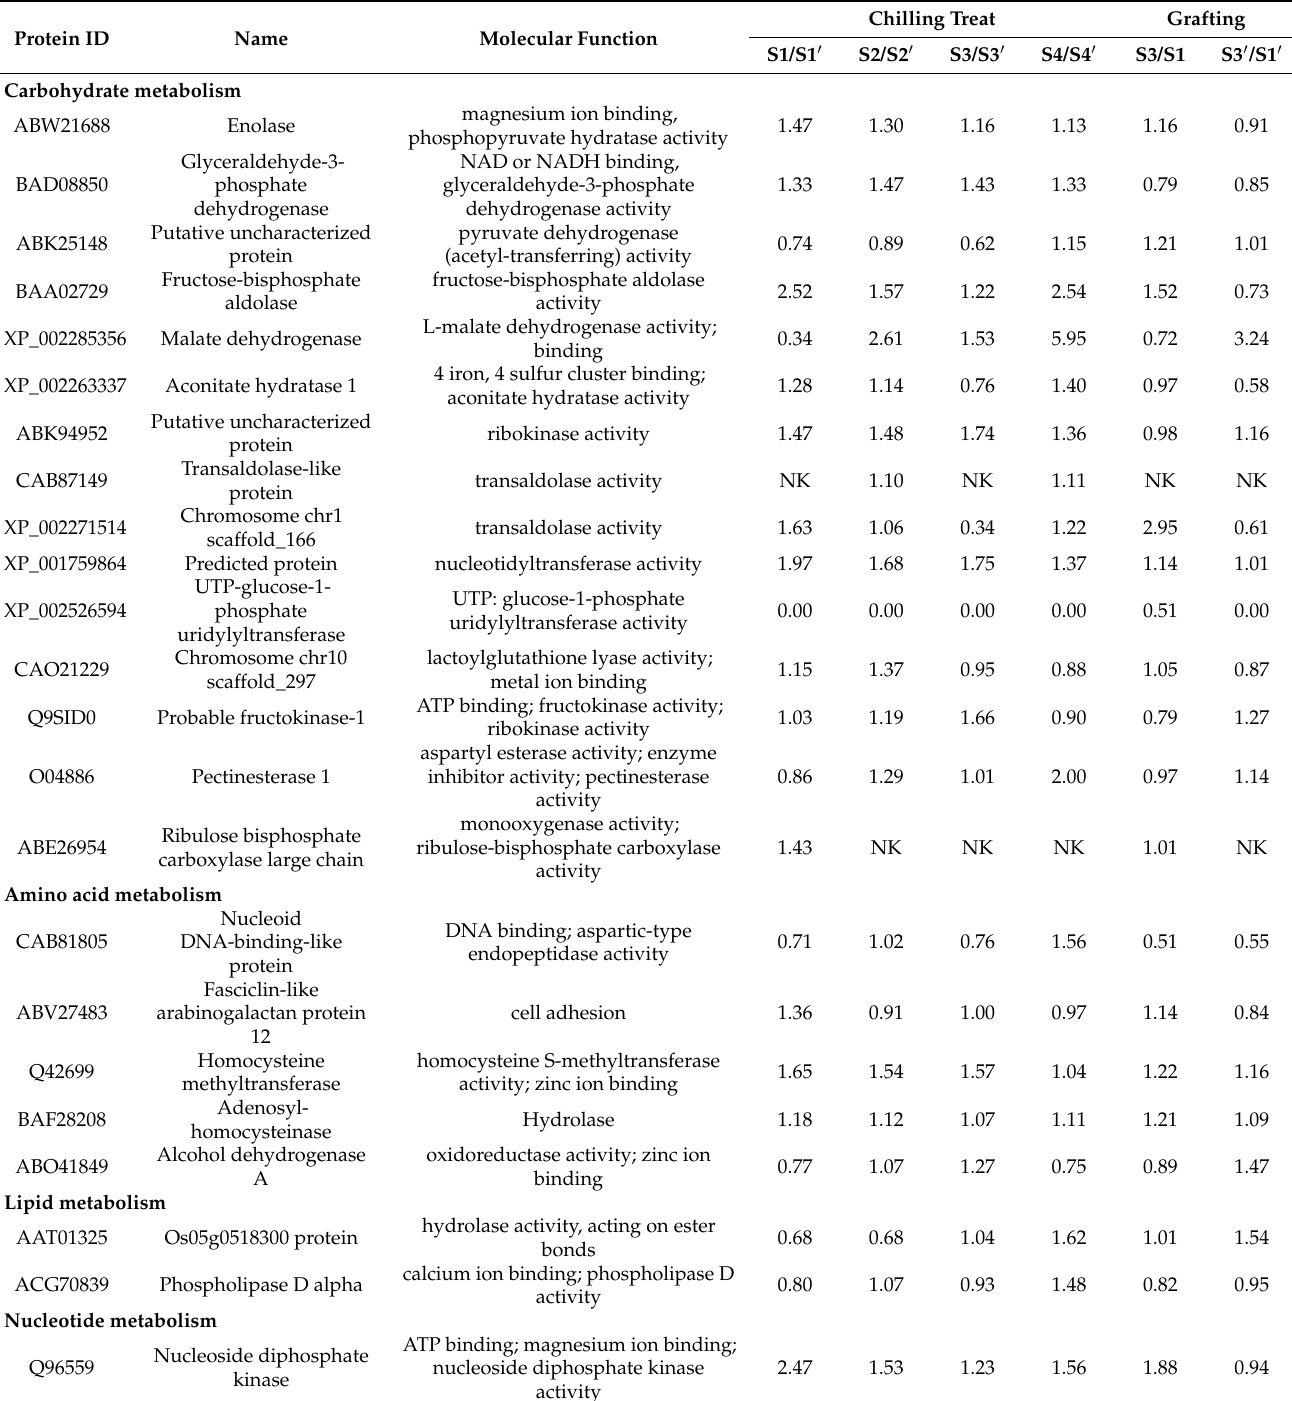
Table 7. Differential proteins related to substance metabolism in the cotton stem bark induced by chilling stress and